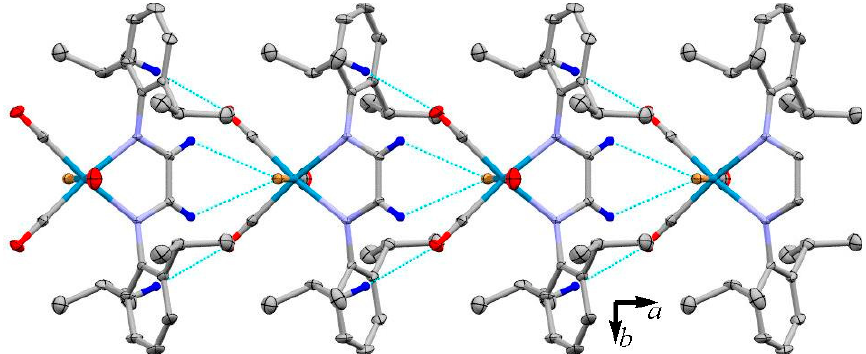
Figure 4. Part the crystal packing of 4, showing one-dimensional extended chain formation along the a -axis through intermolecular C ― H … O and C ― H … Br interaction (H atoms omitted for